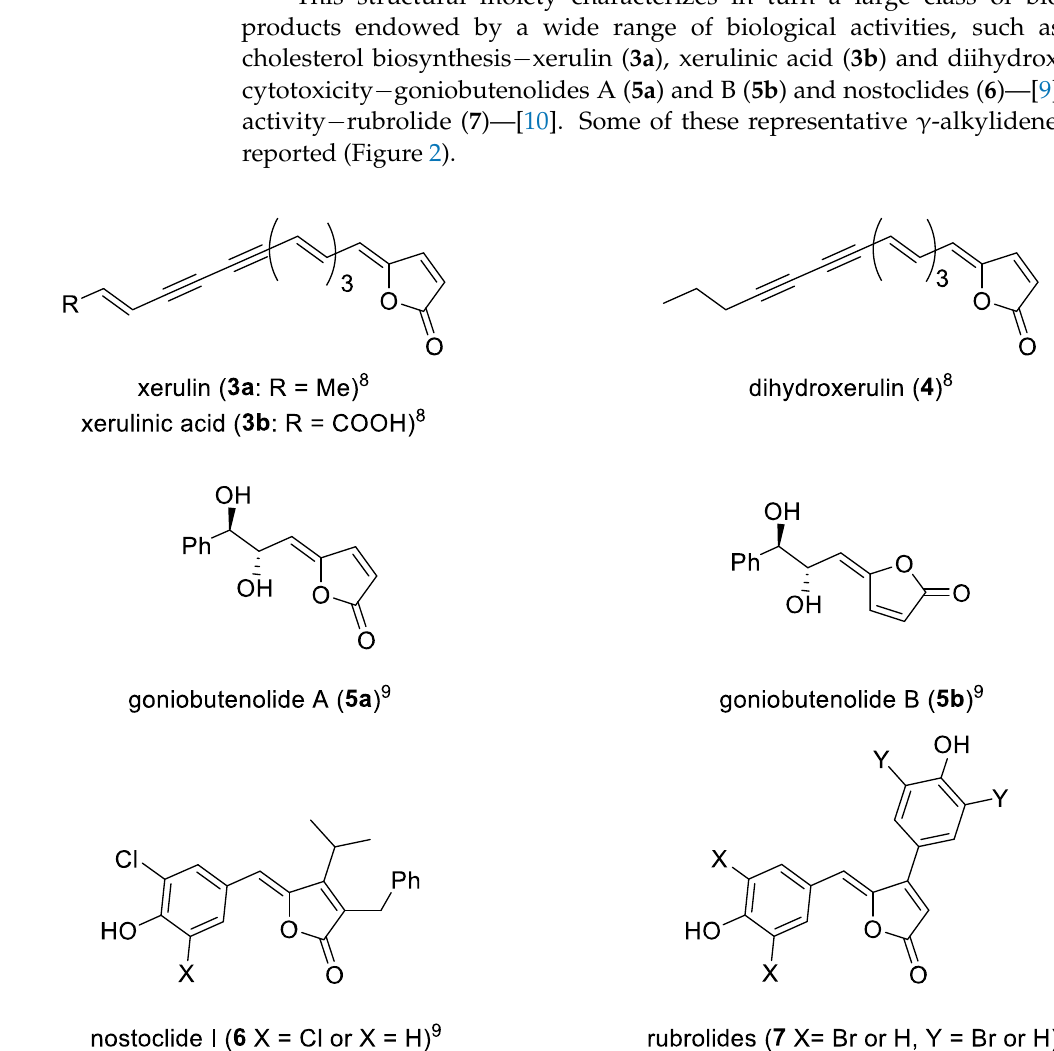
Figure 1. 5-(3 ′ ,4 ′ -dihydroxyphenyl)- γ -valerolactone ( 1 ) and 5-(3 ′ ,4 ′ -bis(benzyloxy)benzylidene)fu- ran-2(5H)-one ( 2 ).